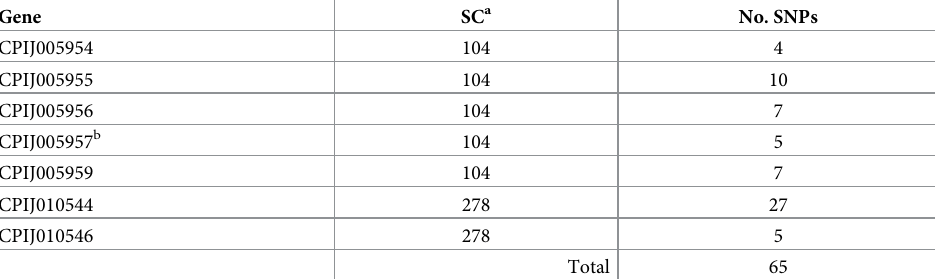
All SNPs in the permethrin list were found in the malathion list, which itself had 19 unique SNPs. a SC, Supercontig number in Cx . quinquefasciatus genome. b Included in the SNPs for this gene are two SNPs in its upstream flanking